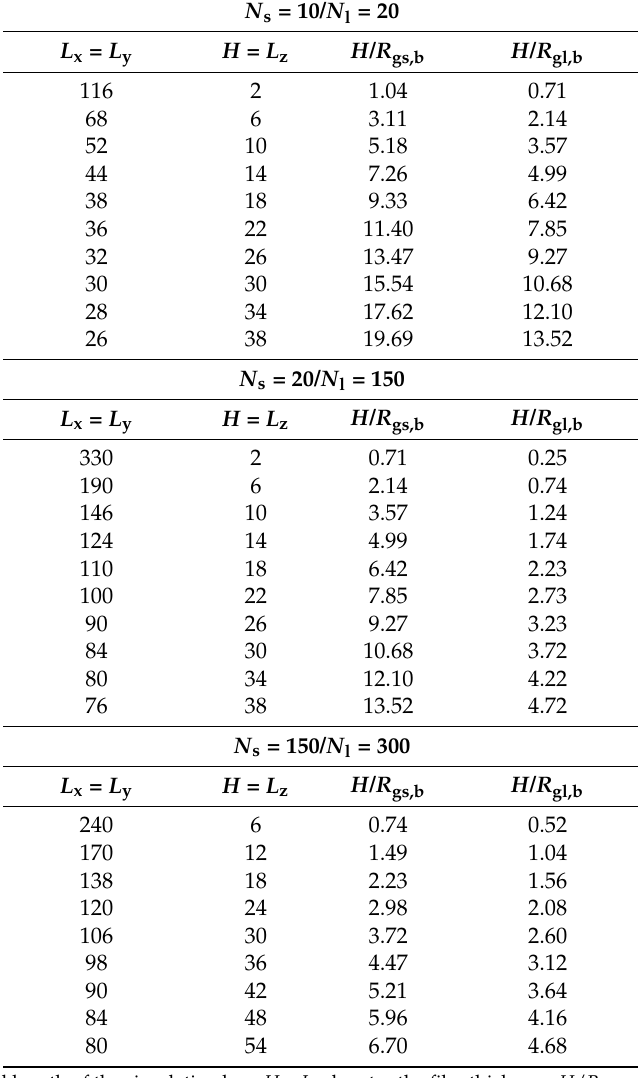
Table 2. Simulation details for bidisperse polymer films 1